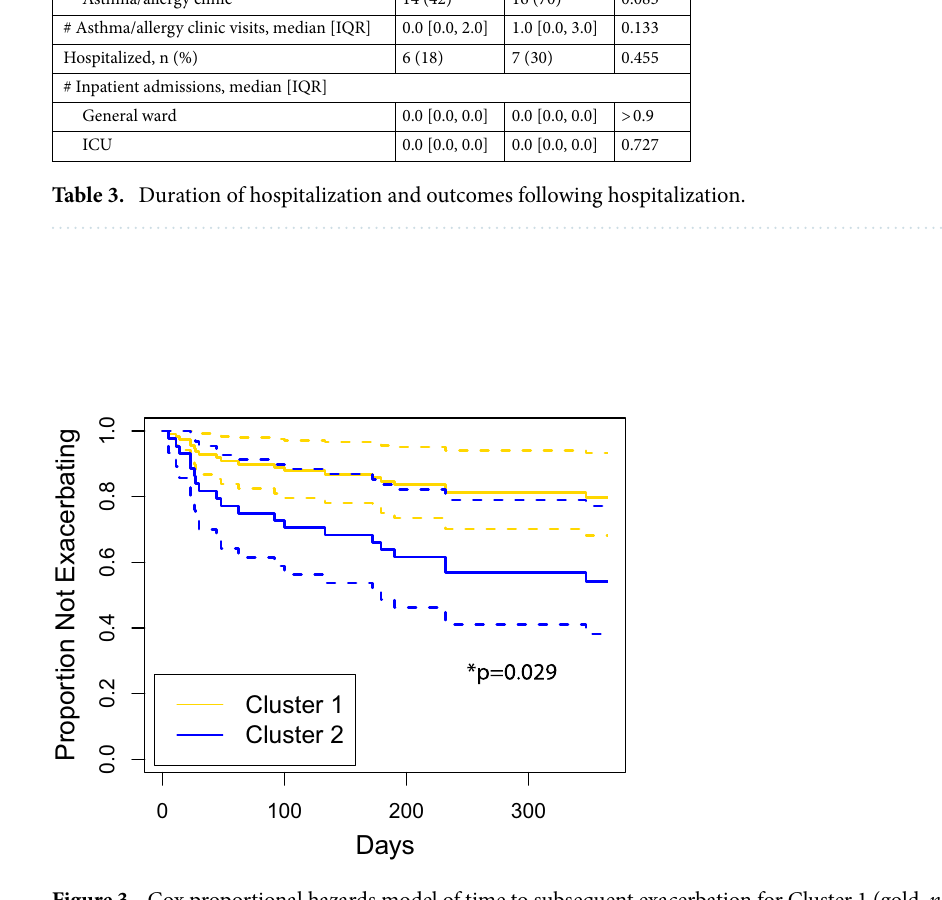
Figure 3. Cox proportional hazards model of time to subsequent exacerbation for Cluster 1 (gold, n = 41) and Cluster 2 (blue, n = 28) over the year following initial discharge. The 95% confidence intervals are represented by dashed lines. Cluster 2 had a hazard ratio of 2.71 (95% CI 1.11–6.64) compared to Cluster 1 ( p =